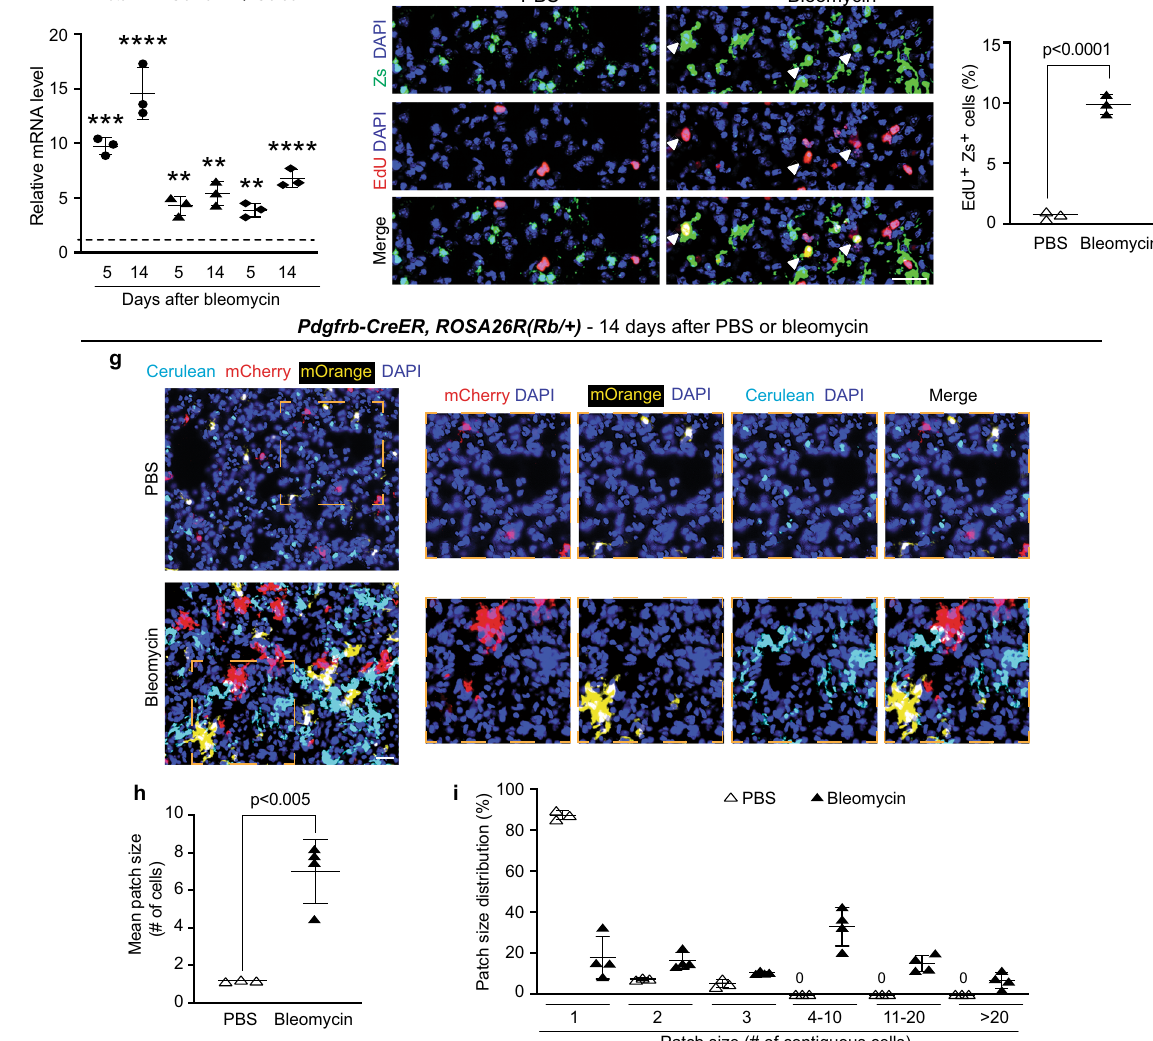
factor inducing myo fi broblast accumulation and fi brosis in the lung upon bleomycin exposure. Once again, similar results were obtained with hypoxia as deletion of Klf4 in PDGFR- β + cells prior to this exposure markedly reduces lung myo fi broblasts (Supplementary Fig. 7b), thereby indicating the relevance of this pathway to multiple pathogenic processes in the